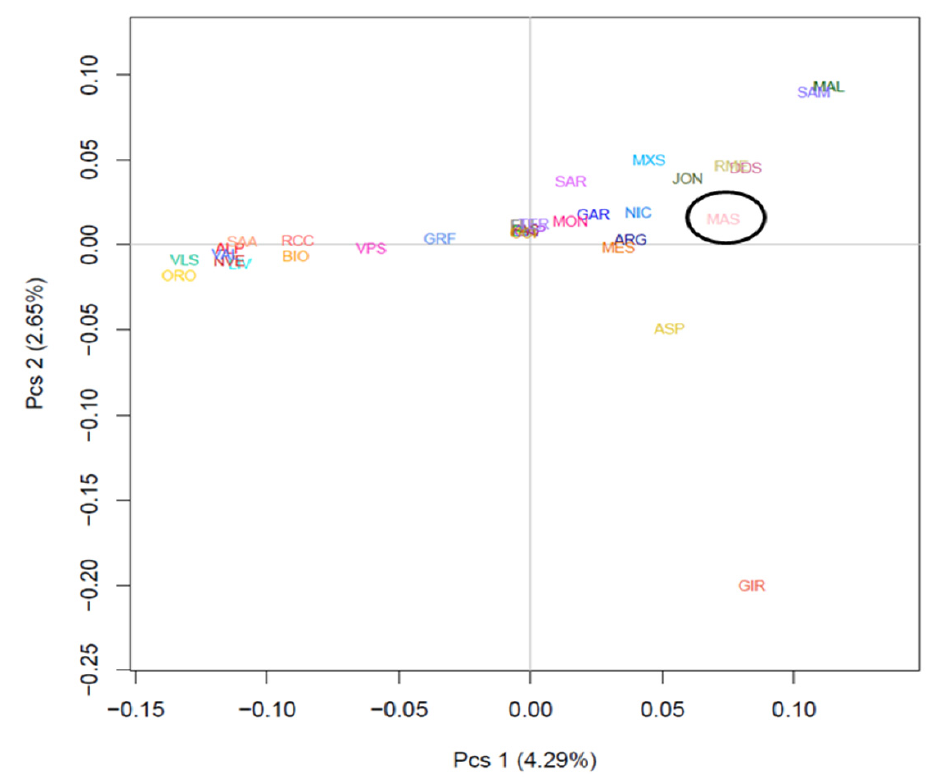
Figure 3. Multidimensional scaling analysis among 32 goat populations using the average coordinates of eigenvalues of C1 and C2. For the full definition of populations, see Table 1 (Mascaruna = MAS). The MDS plot was also created only for the southern goat populations (8POP) (Fig- ure 4). The results indicated a moderate genetic isolation for Mascaruna with a defined cluster. The Sicilian goats (Argentata dell’Etna, Messinese, Maltese and Rossa Mediter- ranea) confirmed their proximity. In particular, the first dimension (7.78%) separated